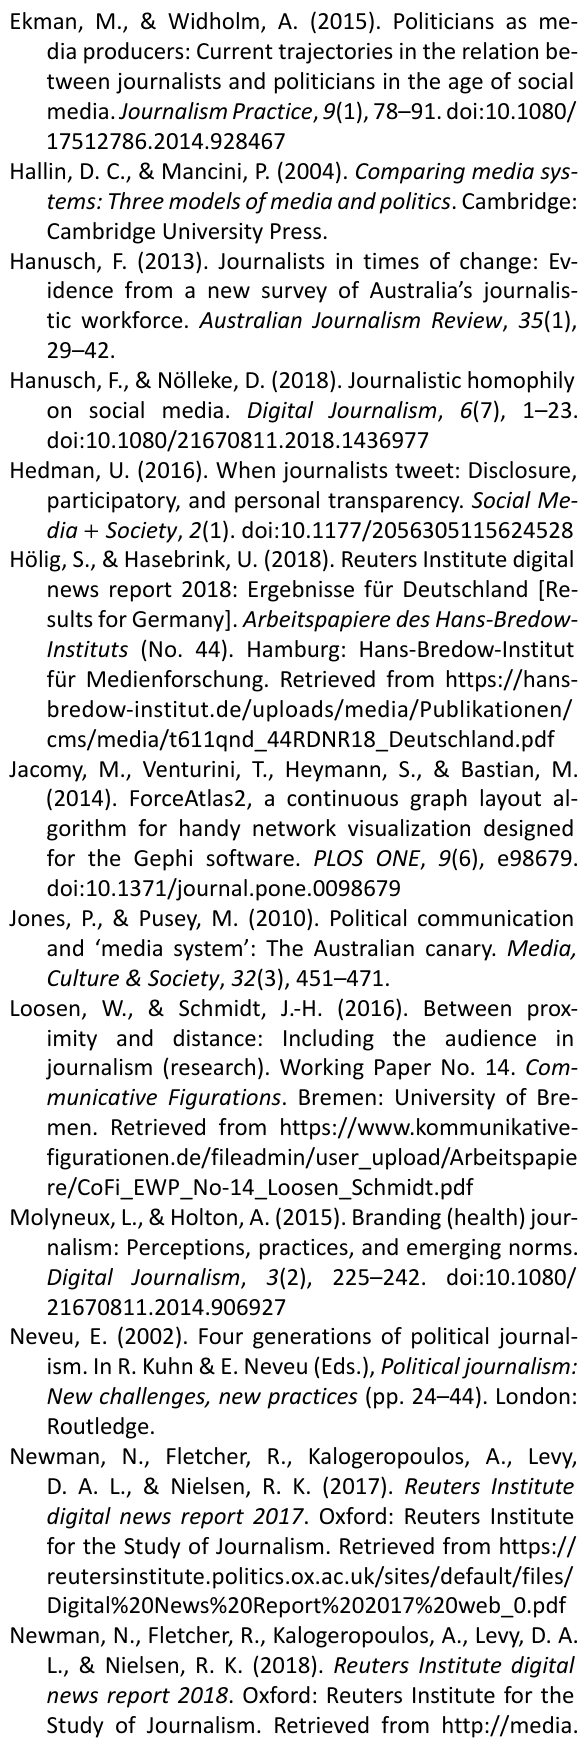
municative Figurations . Bremen: University of